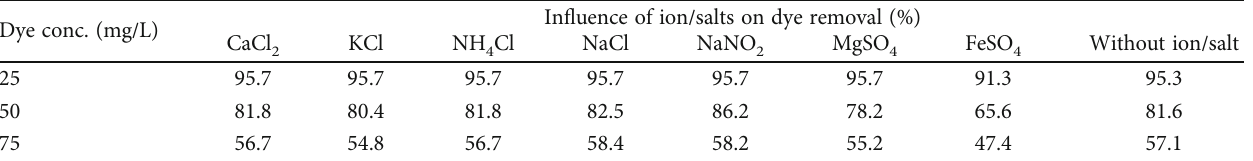
Table 9: In fl uence of additive salts on CV removal onto ACMAS ( time = 30 min , pH = 6 : 0 ). Dye conc. (mg/L)